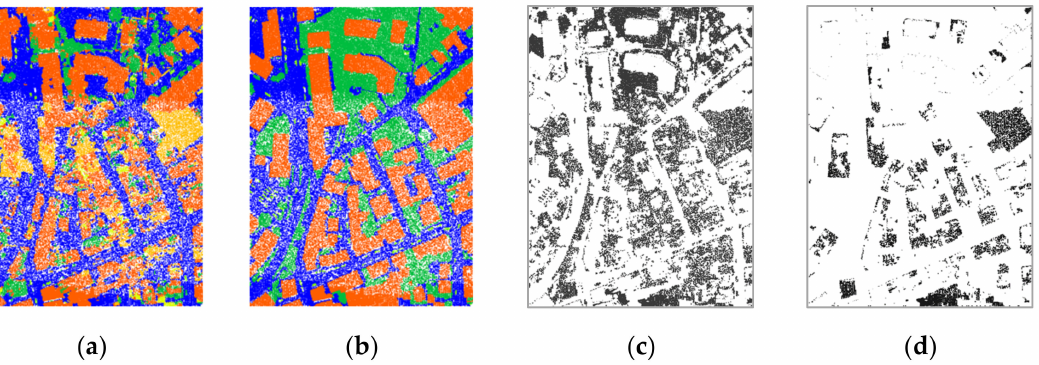
Figure 24. Results of semantic segmentation of new data 1 for Case 3: ( a ) prediction; ( b ) ground truth (i.e., label data); ( c ) difference between prediction and ground truth for all classes; ( d ) difference between prediction and ground truth for building class